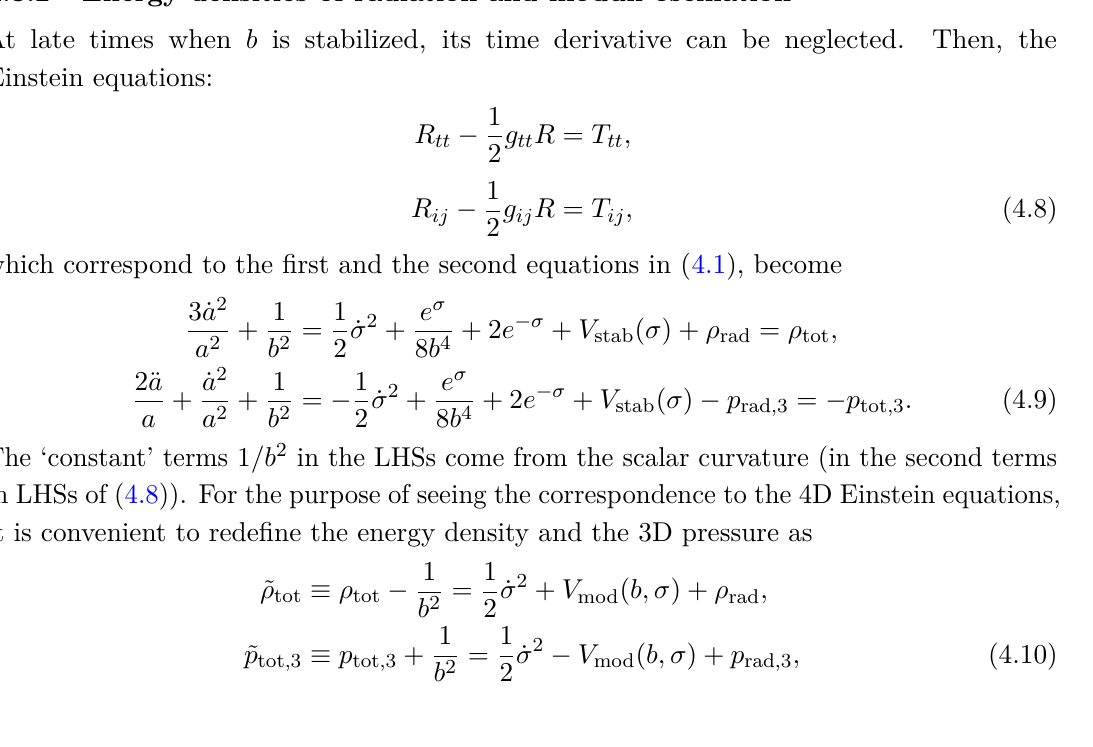
Figure 8. Time evolution of the scale factor b and the dilaton σ in the case of m = 0 . 001 . The value of σ is chosen from the bottom to the top as σ ∗ = 3 × 10 − 4 , 1 × 10 − 3 , 3 × 10 − 3 , respectively. The other parameters are chosen as m 2 b 2 vac